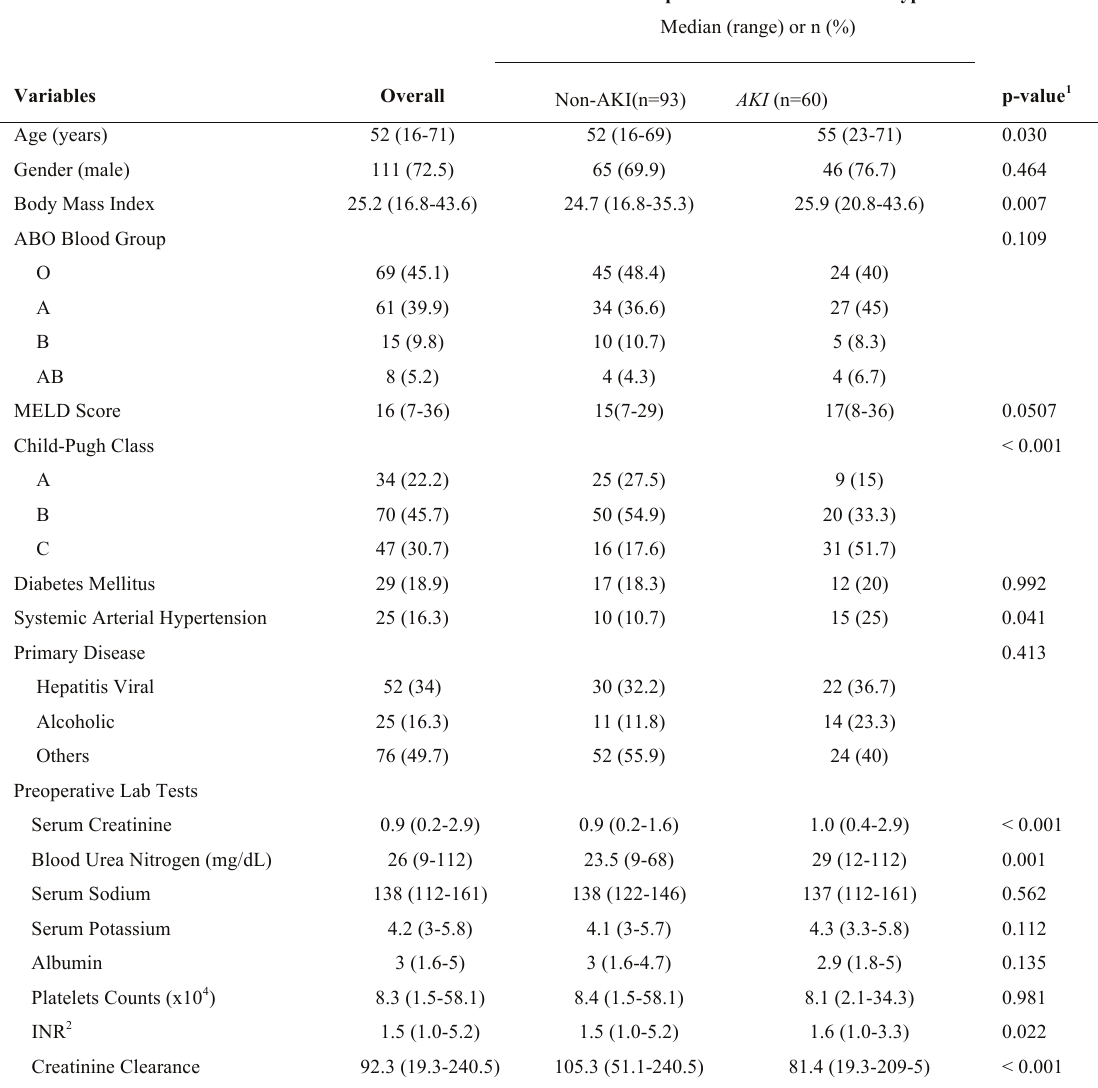
TABLE 1 - Baseline characteristics and descriptive statistics of recipient-related